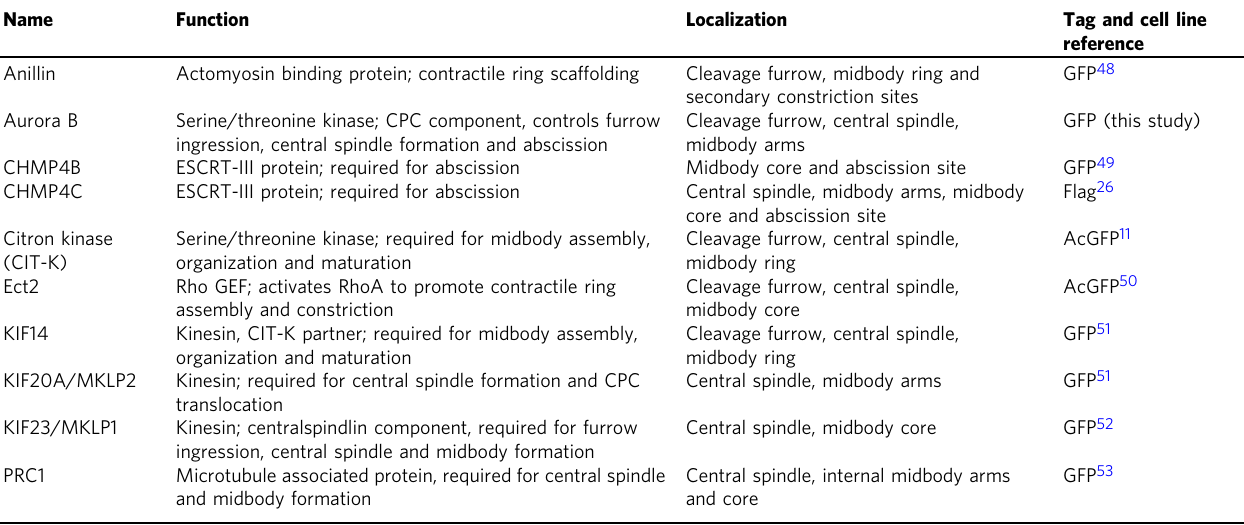
Table 1 Baits used in the AP-MS experiments for the characterization of the midbody